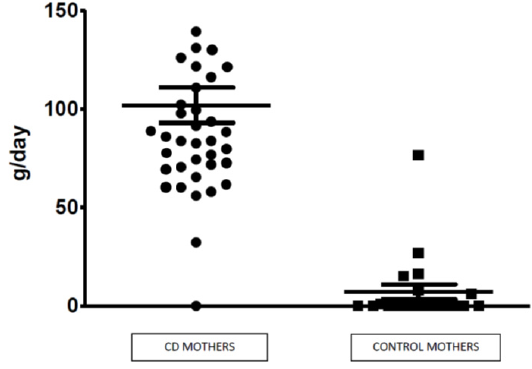
Figure 2. Daily corn intake of CD breastfeeding mothers and control mothers.